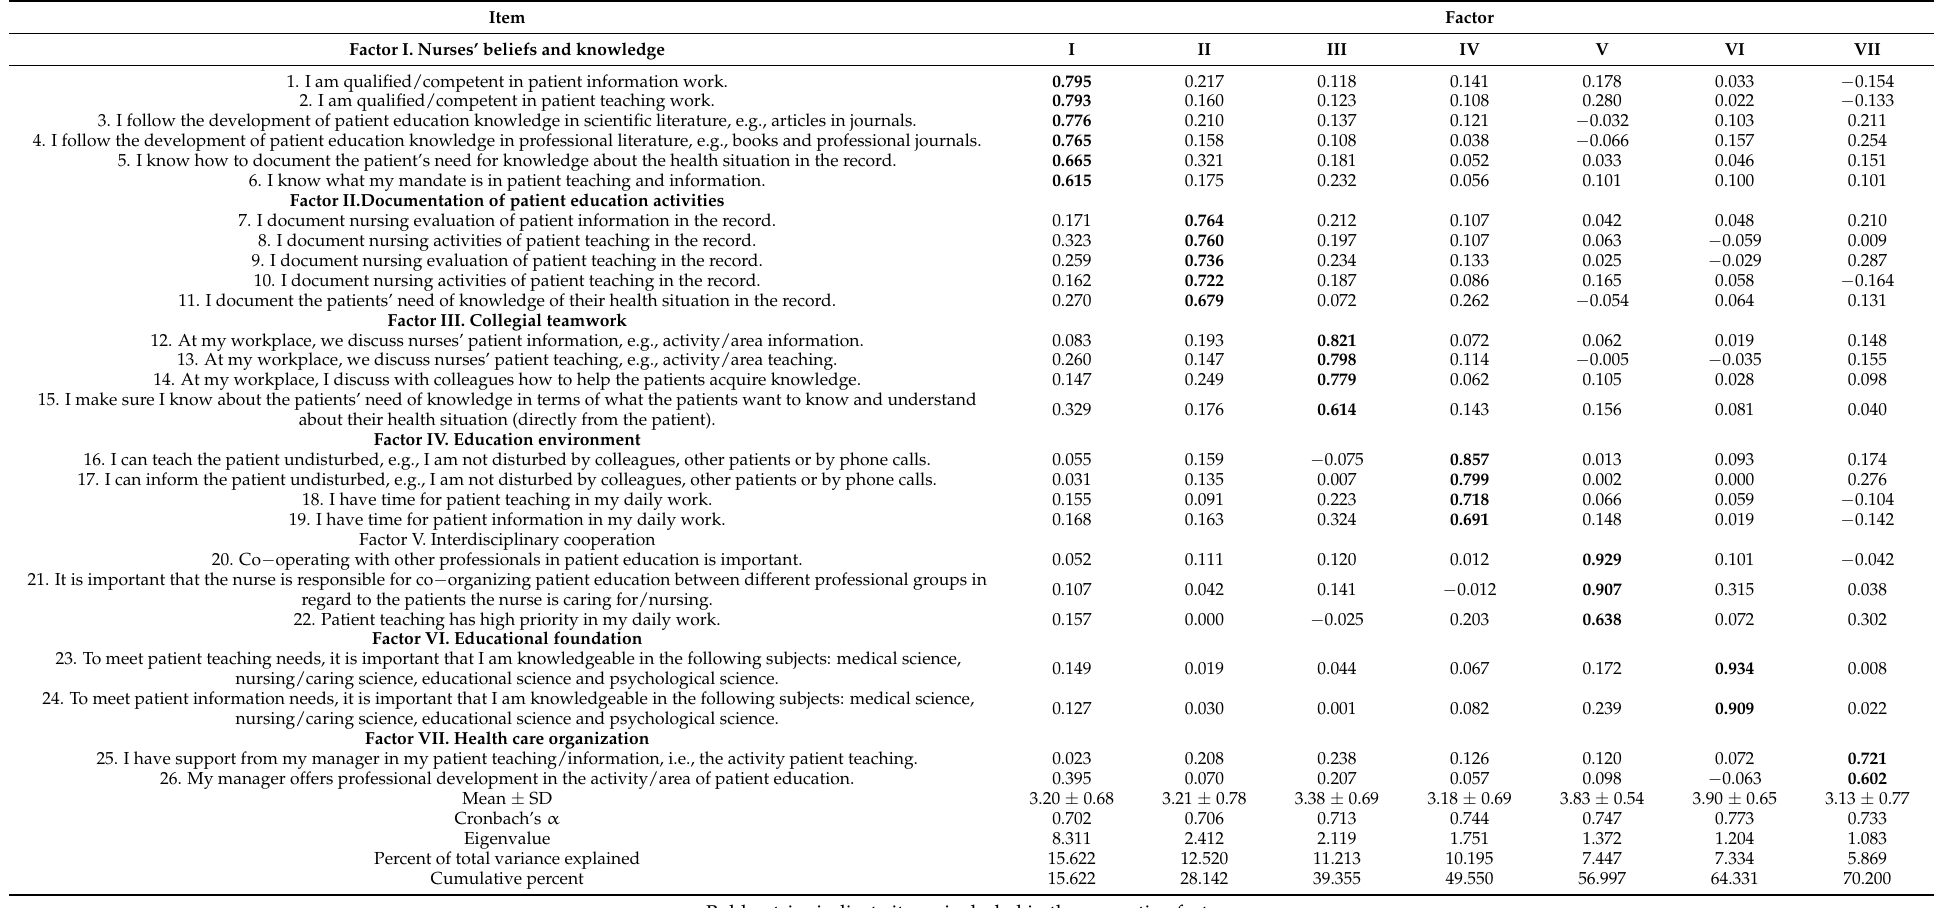
Bold entries indicate items included in the respective